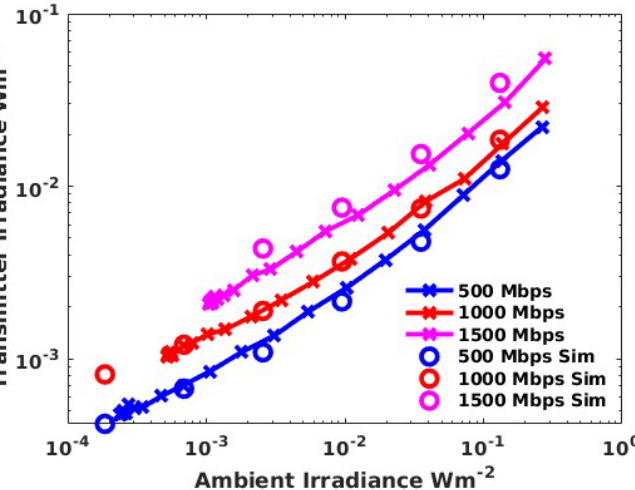
Figure 7. A comparison of the measured and simulated irradiances needed to support three data rates as the incident ambient light irradiance increased. The x axis is the equivalent 405 nm irradiance that generates the same count rate and hence bias current as the incident ambient light.